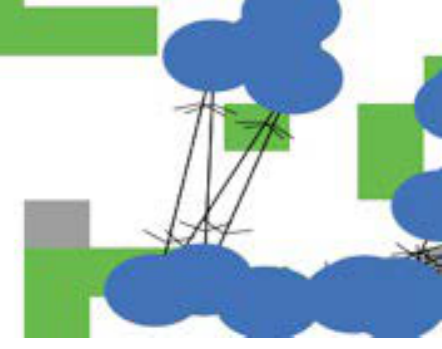
Figure 1. (b) Enlarged section shows agents who have built ties.